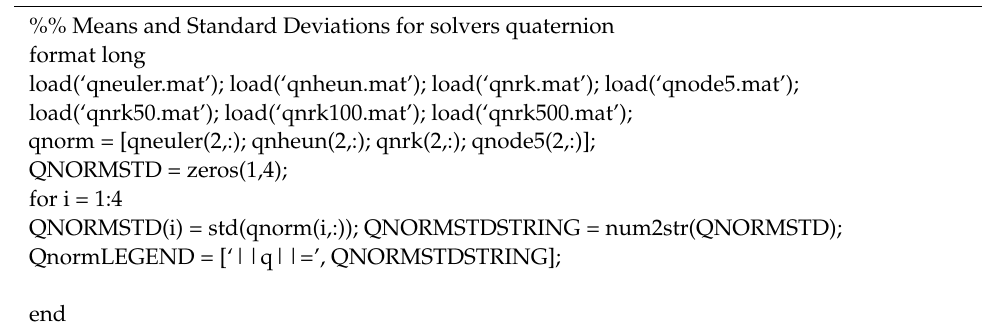
Algorithm A2. StopFcn callbacks for SIMULINK model depicted in Figures